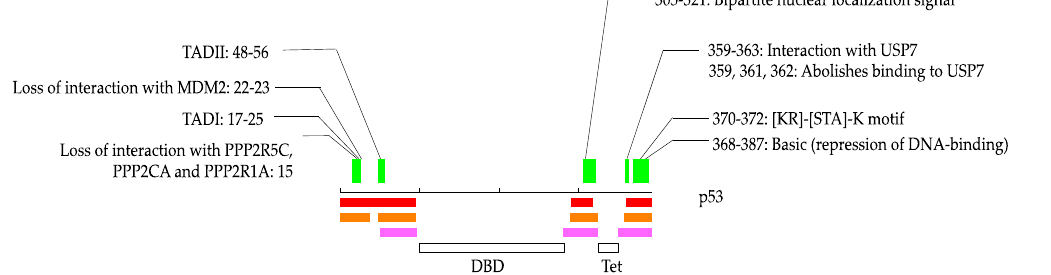
Figure 1. An example of possible protean segment (pProS) definition, illustrated by p53. The black line in the middle represents the amino acid chain, and the intrinsically disordered regions (IDR) predictions are presented below. Pink, orange, and red represent the results by MobiDB-lite, DISOPRED3, and DICHOT, respectively. Regions where any of the two methods predict IDR are defined as IDRs. The green bars represent pProSs, and the annotations defining pProS are shown above with residue numbers of the annotations. DBD: DNA-binding domain; Tet: Tetramerization domain.